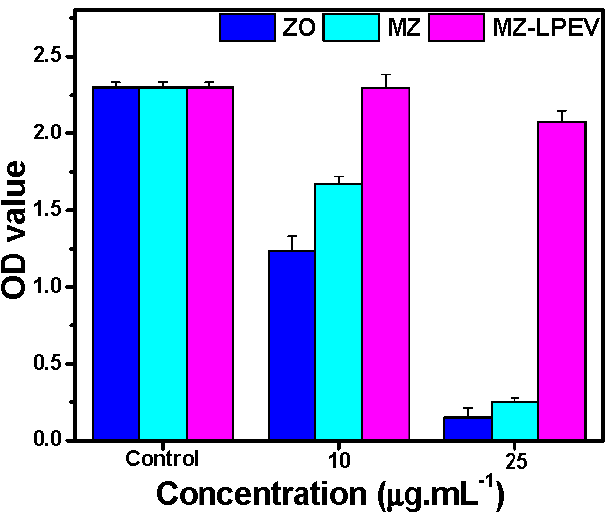
Figure 6. Viability (WST assay) of the human embryonic kidney (HEK 293) cells treated with ZO, MZ, and MZ-LPEV at various concentrations for 48 h. Averaged values from triplicate experiments are shown ( p < 0.05).